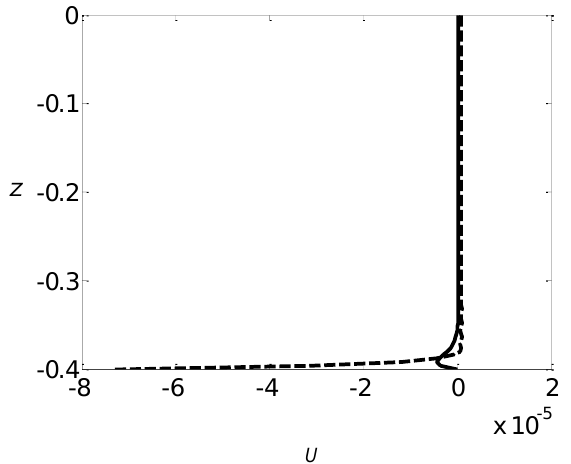
Figure 5. Horizontal velocity profiles for the full (solid line) and pure inertia balance (dashed line) solutions for 0 . 4 z = at 0 . 001 t = .